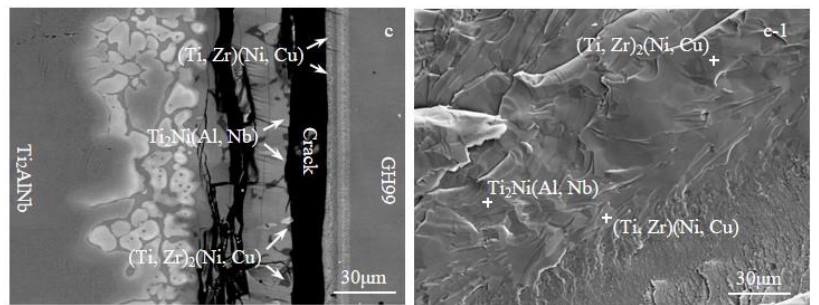
Figure 10. ( a – c ) The fracture paths of Ti 2 AlNb/GH99 joints at 960 °C, 1000 °C and 1040 °C, respec- tively (10 min); ( a-1 – c-1 ) the fracture morphology for 960 °C, 1000 °C and 1040 °C, respectively (10 min).